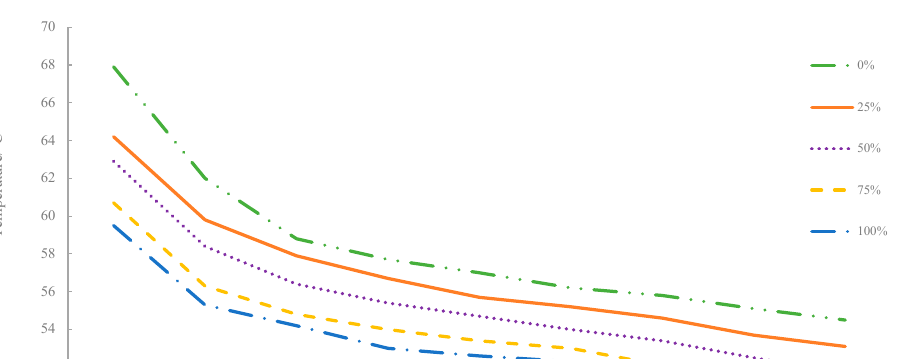
Figure 5. Surface cooling